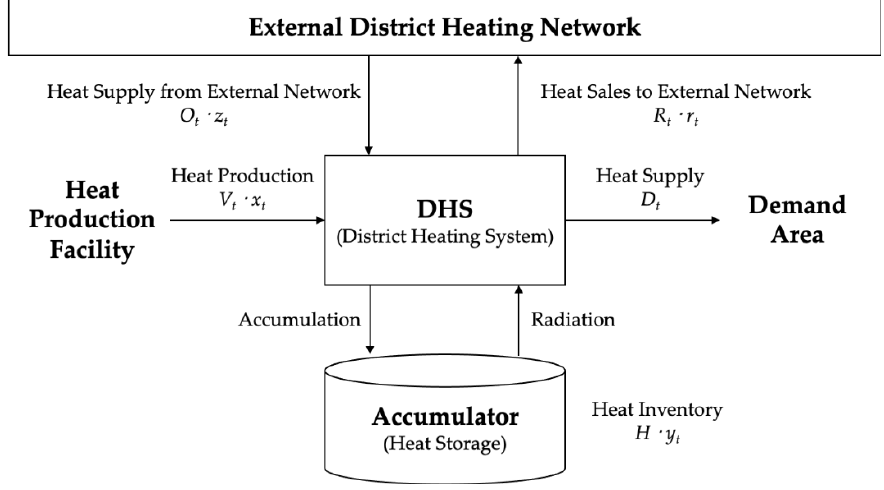
Figure 1. District Heating System Structure.